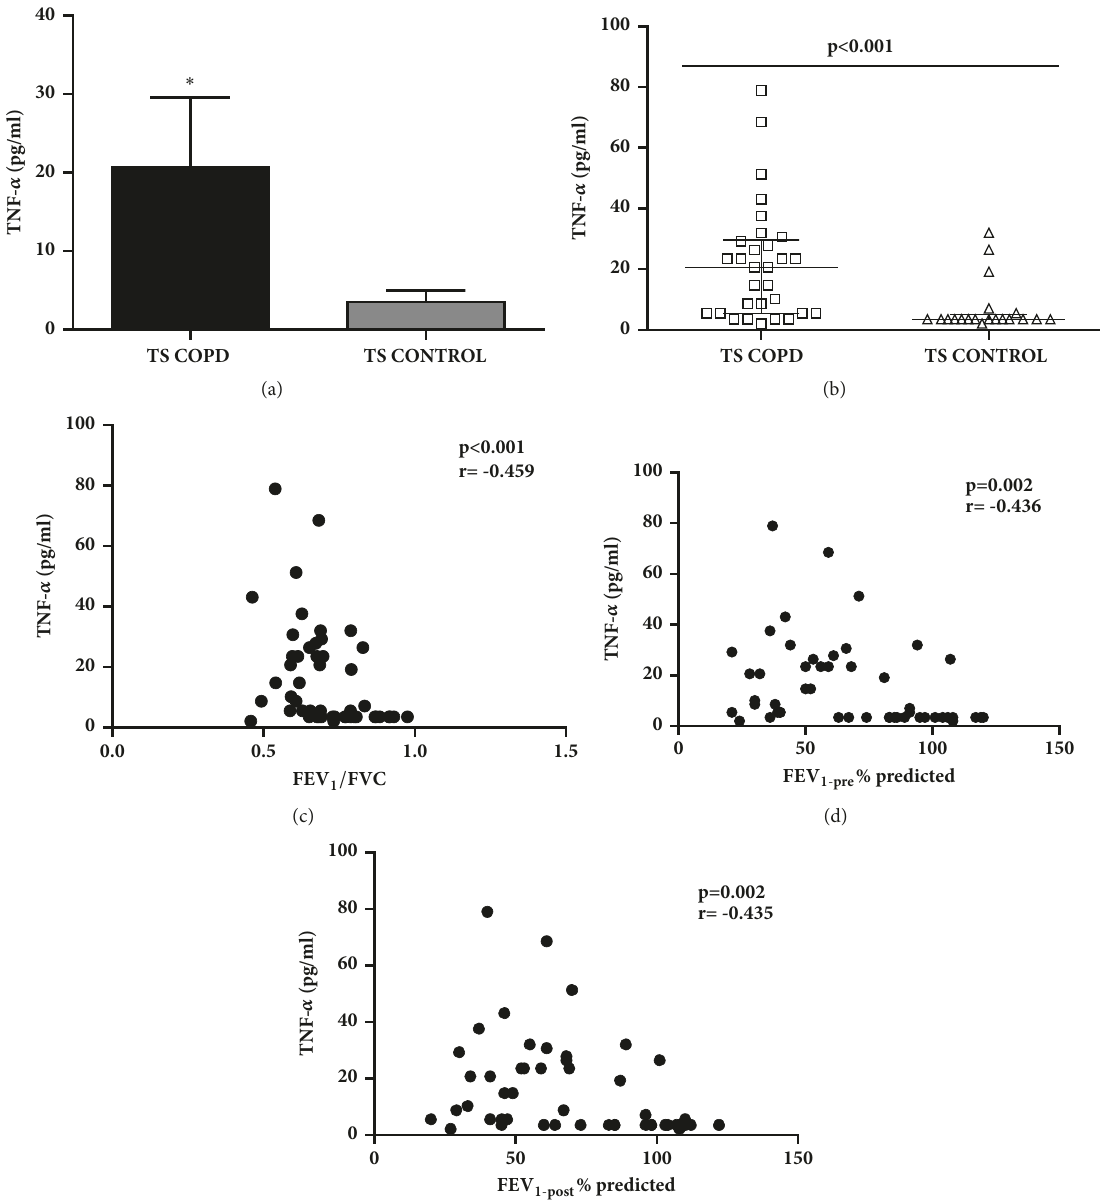
Figure 4: Serum concentrations of tumor necrosis factor alpha (TNF- 𝛼 ) and corresponding correlation with lung function parameters among long-term smokers with or without chronic obstructive pulmonary disease (COPD) . (a, b) TNF- 𝛼 concentrations were increased in TS COPD group compared to TS CONTROL group (p < 0.001); inverse correlation of TNF- 𝛼 concentrations to (c) FEV 1 /FVC, (d) FEV 1( pre ) , and (e) FEV 1( post ) was detected in the study cohort. Data is presented as median (25th-75th percentile); TS COPD: n=30 and TS CONTROL: n=20; ∗ p < 0.05 was considered as statistically significant. COPD : chronic obstructive pulmonary disease; FEV 1 /FVC : forced expiratory volume 1 second postbronchodilator challenge/forced vital capacity; FEV 1 : forced expiratory volume 1 second prebronchodilator (pre) challenge; FEV 1 : FEV 1 postbronchodilator challenge; TS COPD : tobacco smokers with COPD; TS CONTROL : tobacco smokers (post)